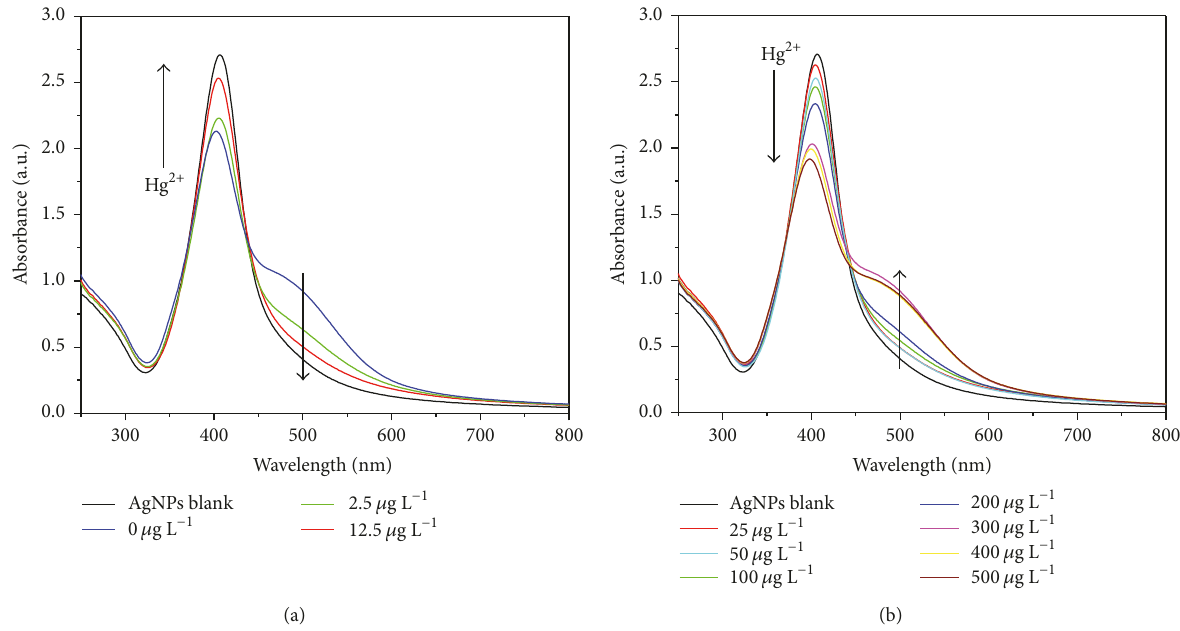
Figure 3: UV-Vis absorption responses of starch-stabilized AgNPs recorded 5 min after the addition of Hg 2+ with various concentrations: (a) 0–12.5 𝜇 g L −1 Hg 2+ and (b) 25–500 𝜇 g L −1 Hg 2+ in the presence of 0.005 molL −1 HNO 3